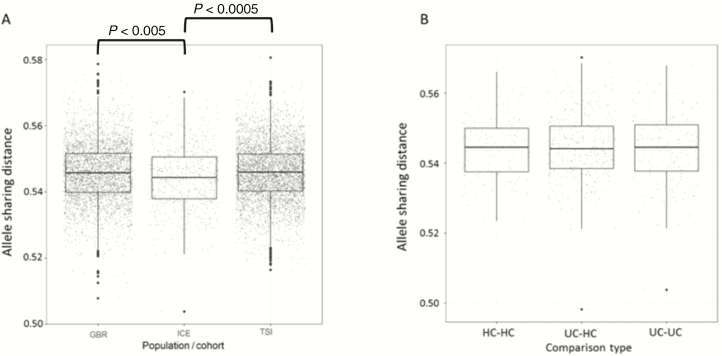
Box plots of pairwise ASD across the exome in sample groups. A, 1000 Genomes Project GBR population, all samples in this study (ICE), 1000 Genomes Project TSI population. B, HC, UC patients, and UC-HC, UC.